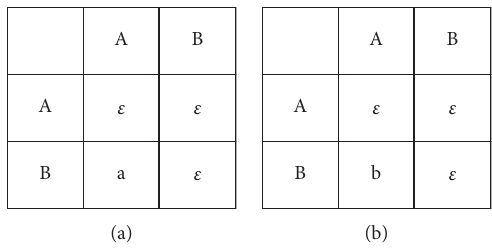
Figure 2: (a) Matrix F